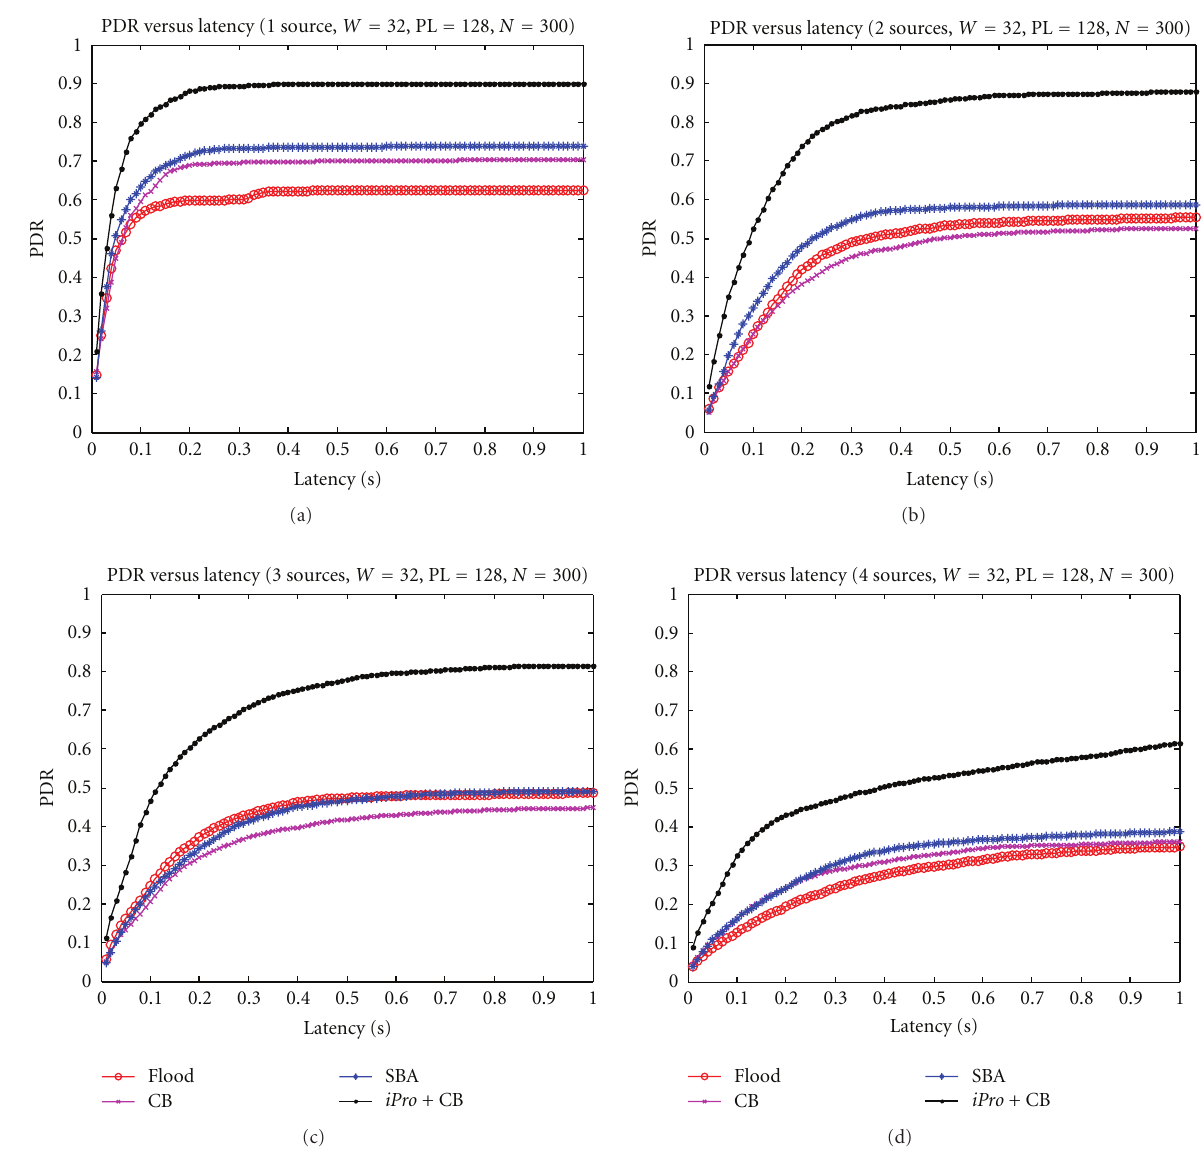
Figure 8: Latencies versus PDRs in multisource multihop broadcast